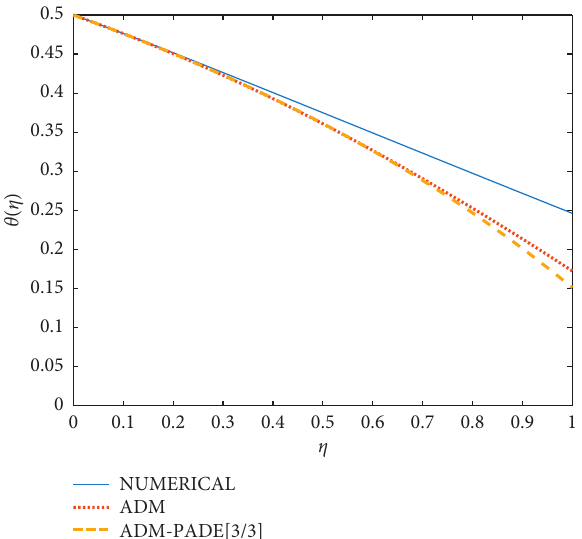
Figure 6: Comparative plot of temperature profile.